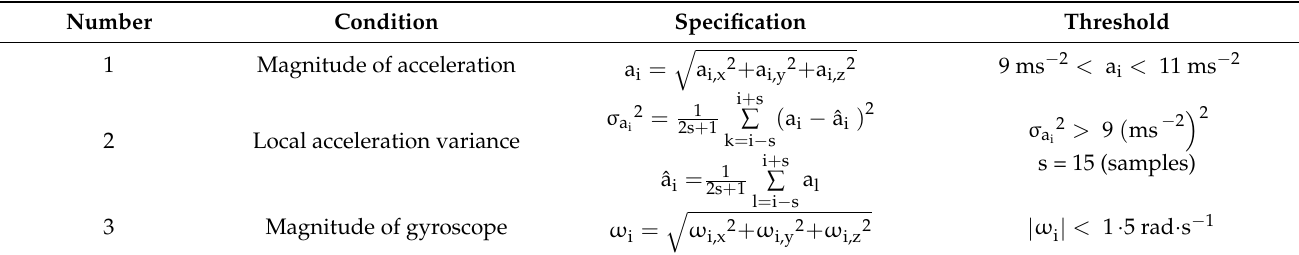
Table 1. Triple conditions of the stance detection phase. Condition Specification